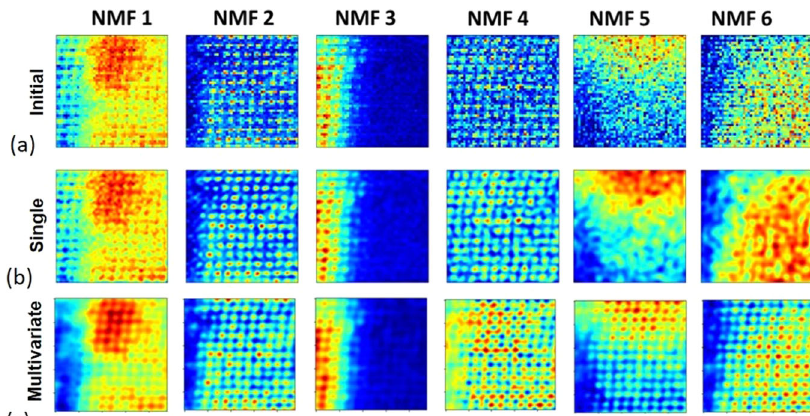
Fig. 9 Comparison of individual and multivariate GP reconstruction of NMF loading maps. Shown are (top row) original NMF components (similar to Fig. 1) and (middle row) individual GP reconstructions. Shown in the bottom row are multivariate GP reconstruction on all six components simultaneously. Kernel constraints used were the same for the individual and multivariate GP. Note that the full 48 × 48 spatial pixel images are analyzed but due to memory constraints, resampling for multivariate GP reconstruction is by a factor of 2. Corresponding spectral components remain